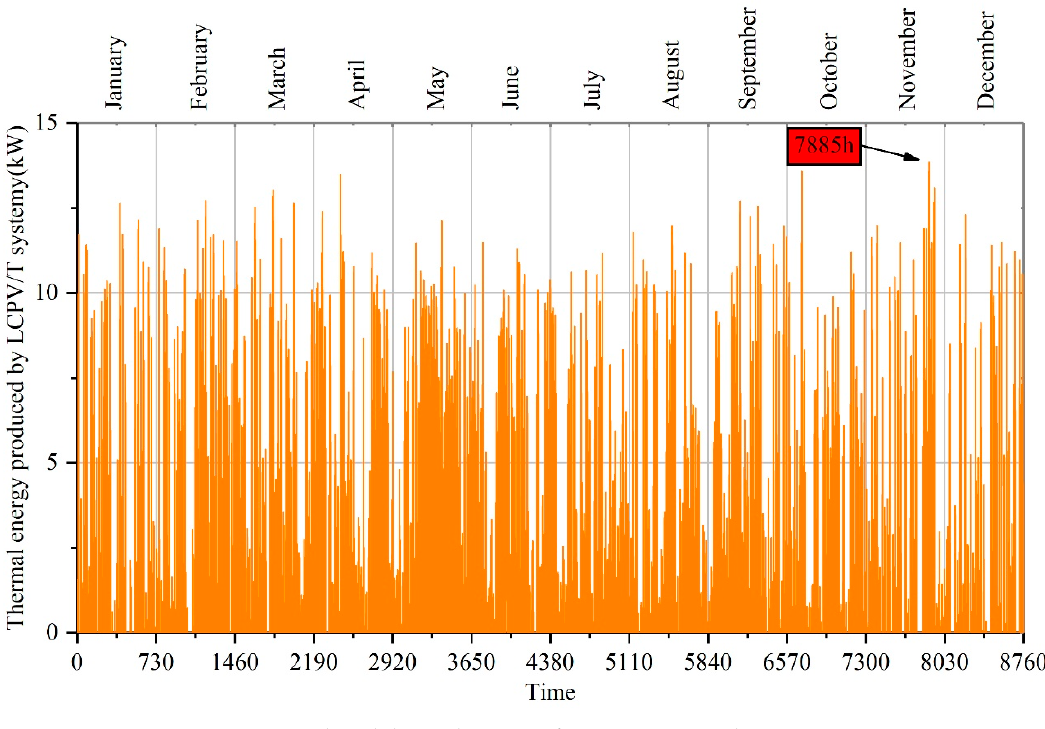
Figure 7. Produced thermal energy of LCPV/T system during a year.